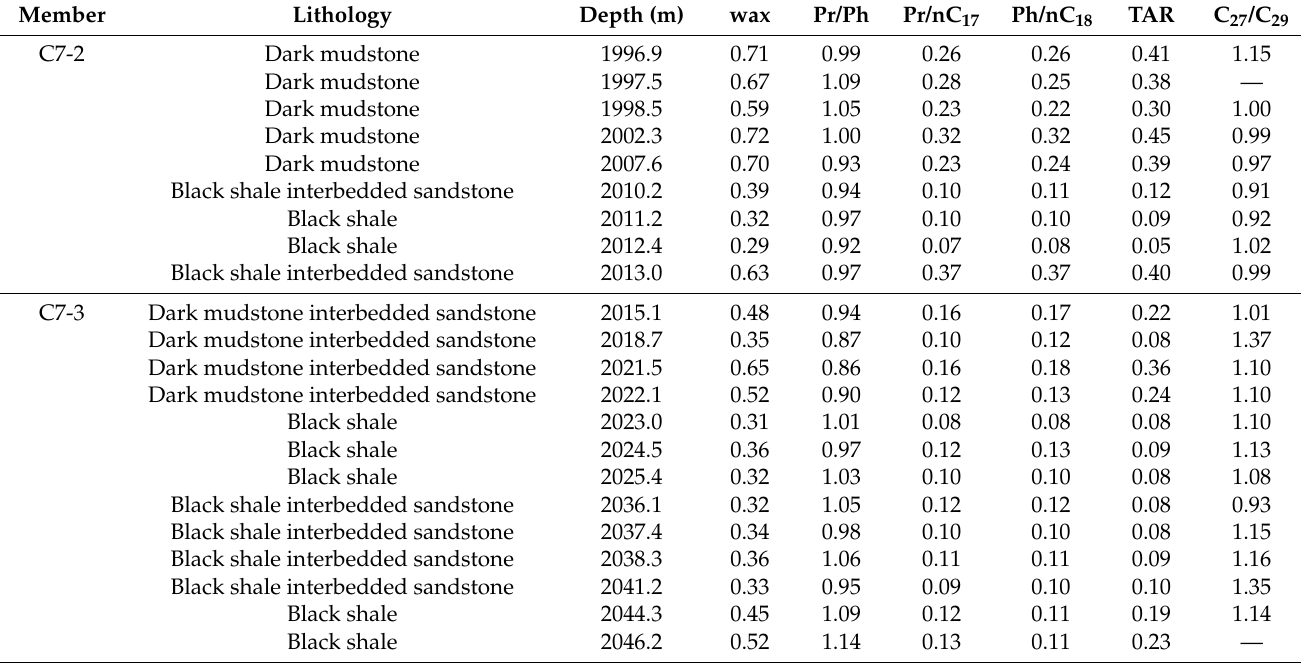
Table 2. Biomarker ratios for the source rock samples.